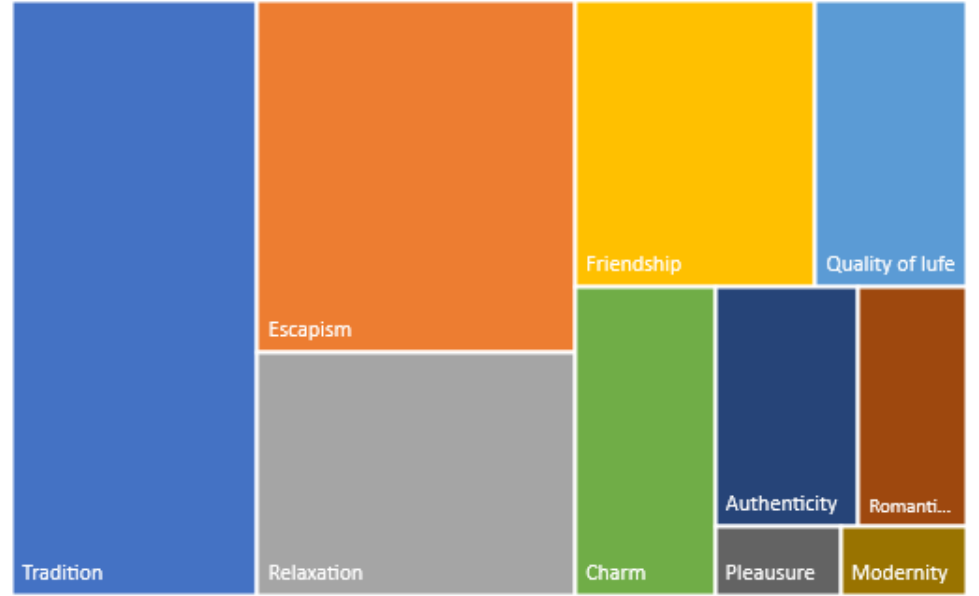
Figure 8. Emotional values of Ribeira Sacra wineries’ Instagram profiles. Source: Own Elaboration.